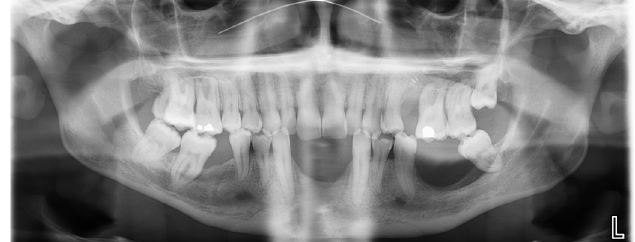
Fig. 6. Panoramic radiograph showing new bone formation of mandibular lesions 3 years after the